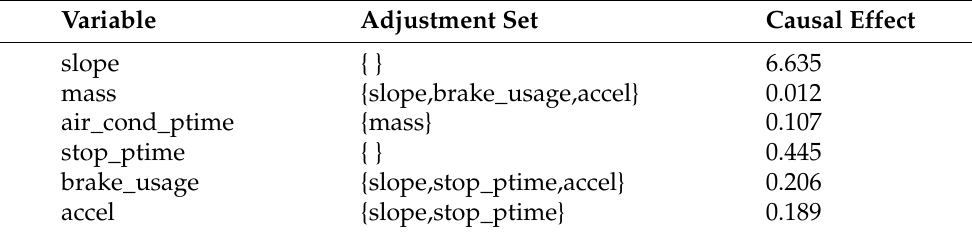
Table 4. Causal effects of variables on target variable fuel_per_km